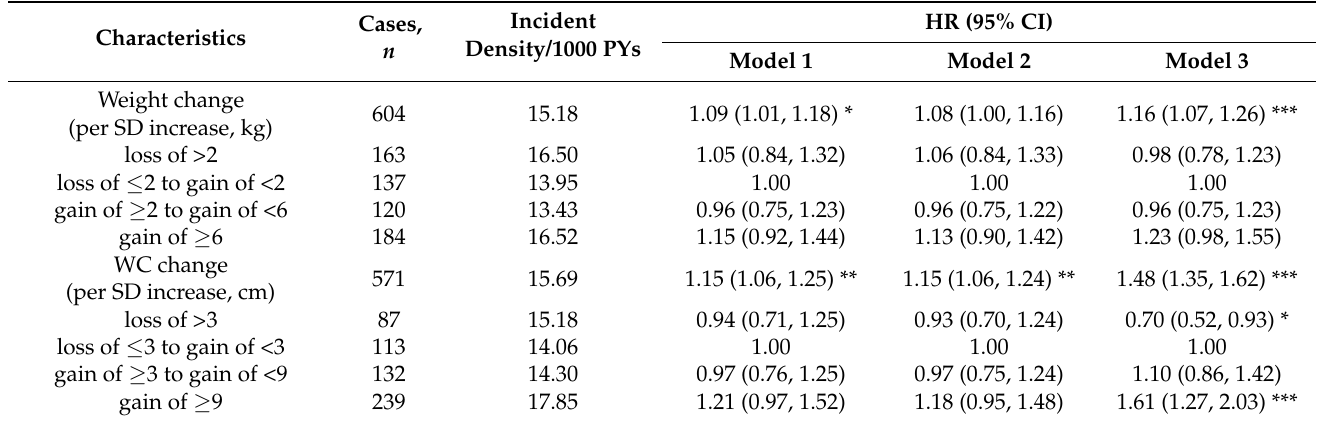
Table 3. The incident risk of T2DM associated with weight change and WC change from baseline to follow-up. Characteristics